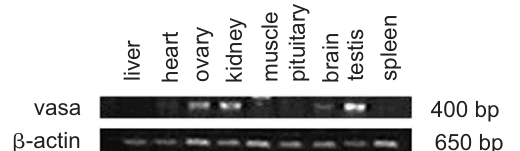
Figure 3. Tissue-specific expression of RnVasa in adult Rana nigromaculata . Total RNA was extracted from different adult tis- sues: liver, heart, ovary, kidney, muscle, pituitary, brain, testis and spleen. After the Dnase treatment, samples were subjected to RT- PCR. (cid:4) -actin was used as a positive